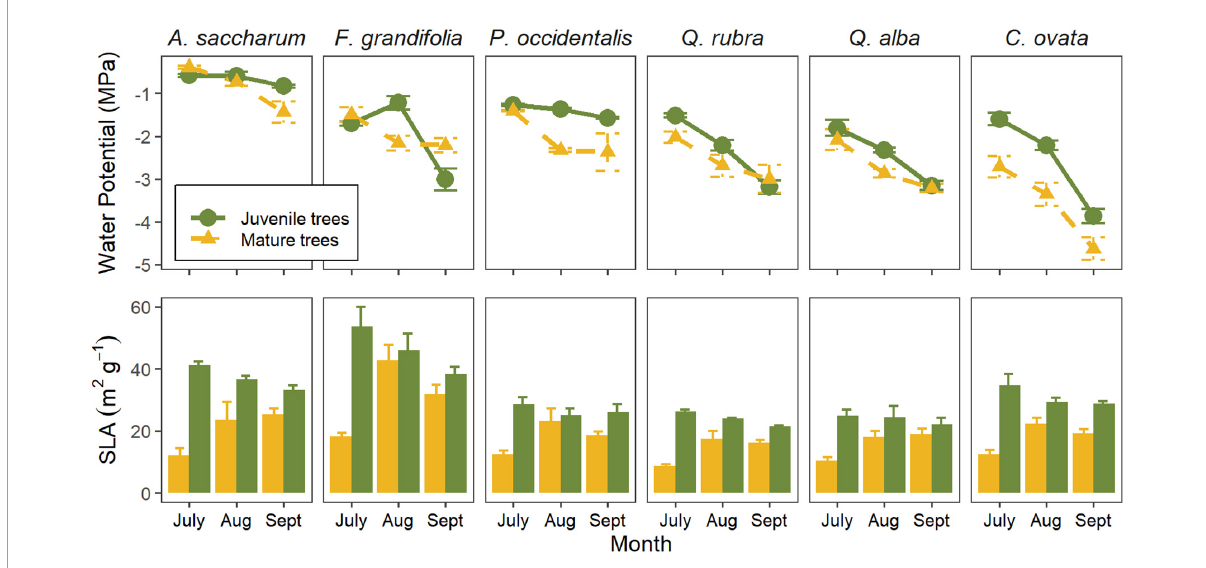
FIGURE4 Physiological parameters collected in co-existing juvenile and mature tree species. (Top row) mean midday leaf water potential during the driest part of the 2019 growing season for juvenile trees compared to co-existing mature trees of the same species (Bryant et al., 2022). (Bottom row) mean specific leaf per area (SLA) during the same time for the same trees. Vertical bars represent SE among individuals ( n = 3 trees per species per age class) with a 95% confidence